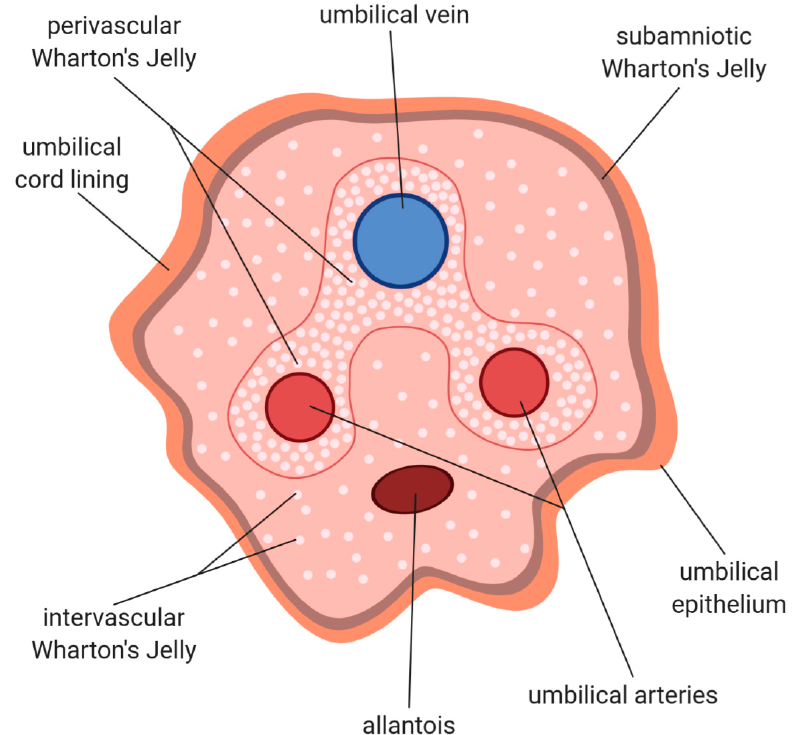
Figure 1. The schematic cross section of human umbilical cord covered with the umbilical cord lining, with an outer layer of umbilical epithelium, and three umbilical vessels embedded in Wharton’s jelly. Both umbilical vein and umbilical arteries are devoid of tunica adventitia. Between the latter, the residual allantois is located. Wharton’s jelly is a gelatinous connective tissue composed of extracellular matrix abundant in glycosaminoglycans (mostly hyaluronic acid), collagen fibers and myofibroblasts, and occasional mast cells. Stromal cells of Wharton’s jelly are most abundant in the proximity of the umbilical vessels in perivascular Wharton’s jelly, becoming less abundant in intervascular Wharton’s jelly, with the least amount of stromal cells in subamniotic Wharton’s jelly. The degree of stromal cells’ differentiation towards myofibroblasts is the highest near the vessels, gradually decreasing towards the umbilical epithelium.